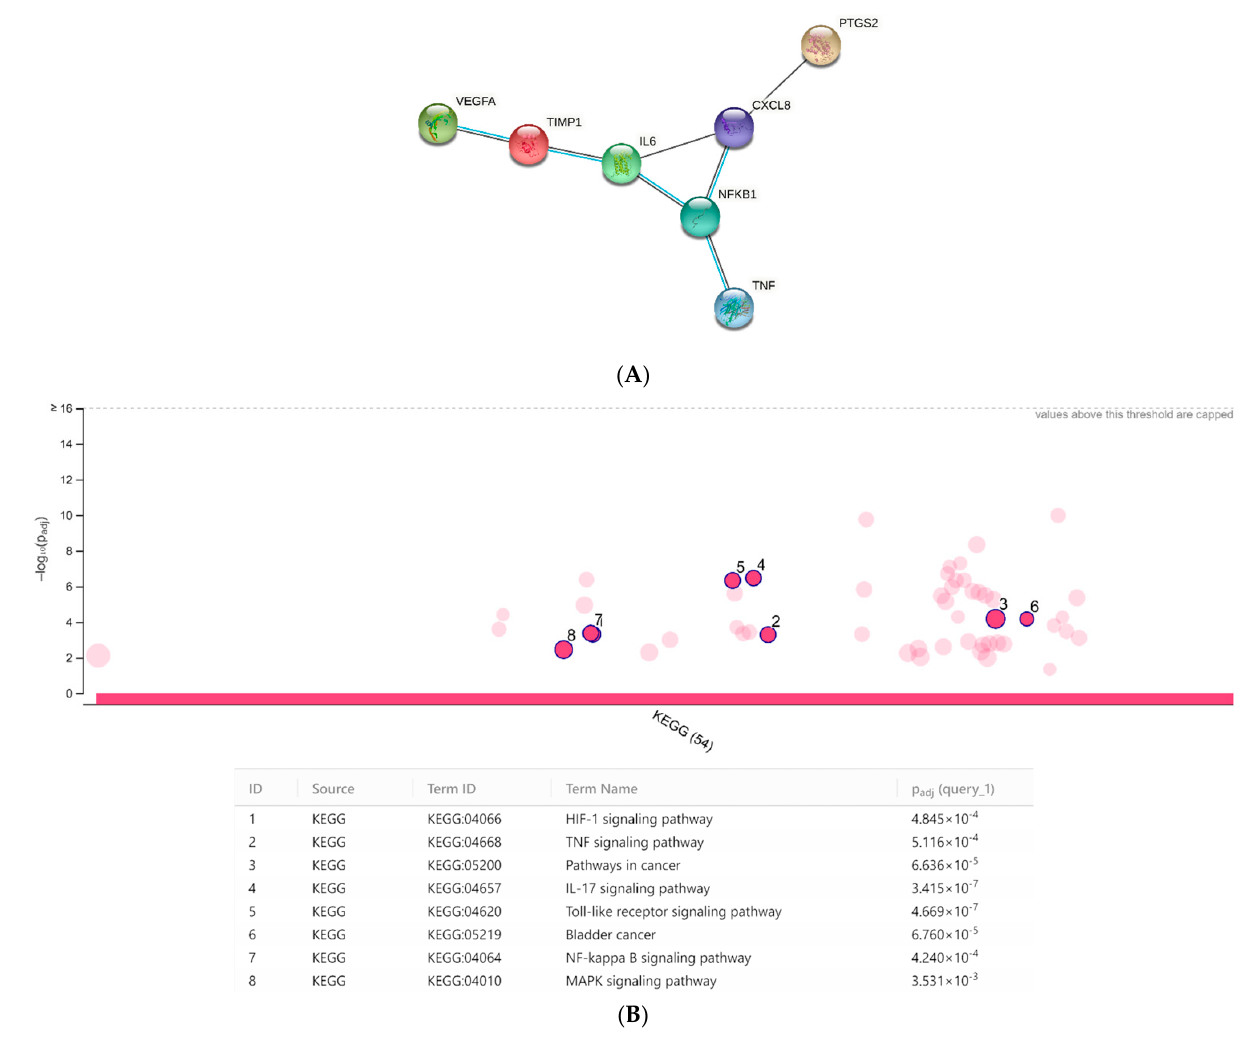
Figure 8. Protein–protein interactions ( A ) and KEGG analysis ( B ) conducted through the bioinformatics platforms STRINGH and g:Profiler, respectively.